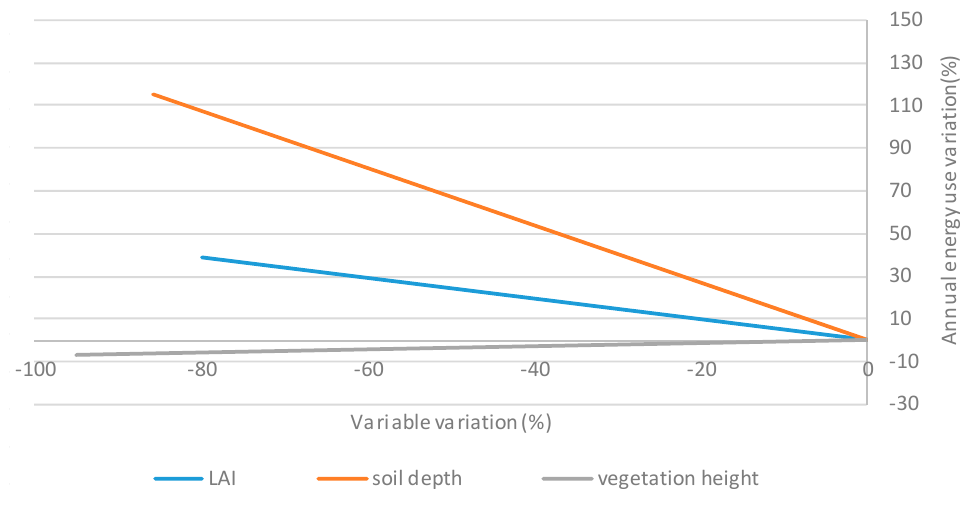
Figure 8. Impact of vegetation and substrate variation on annual energy use.